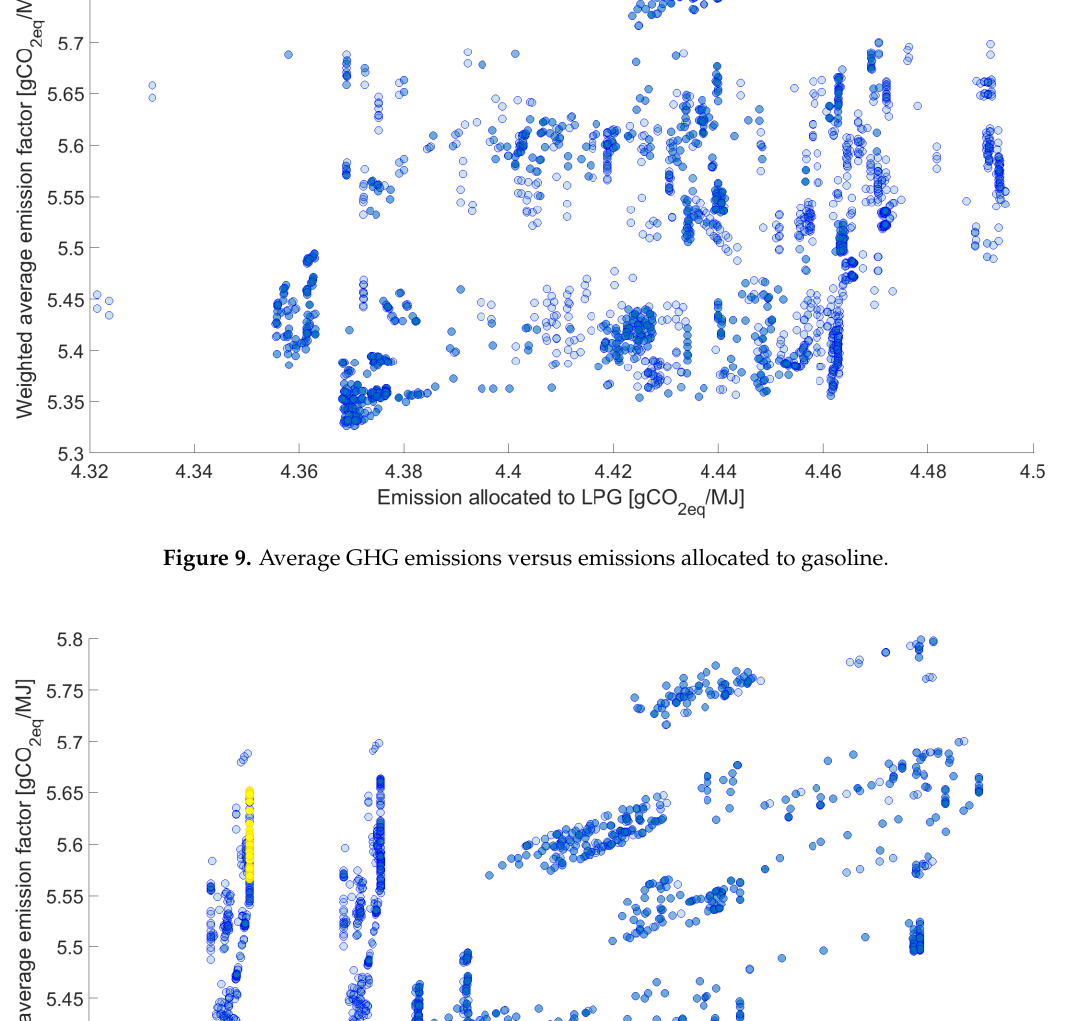
Figure 8. Average GHG emissions versus emissions allocated to gasoline 95.